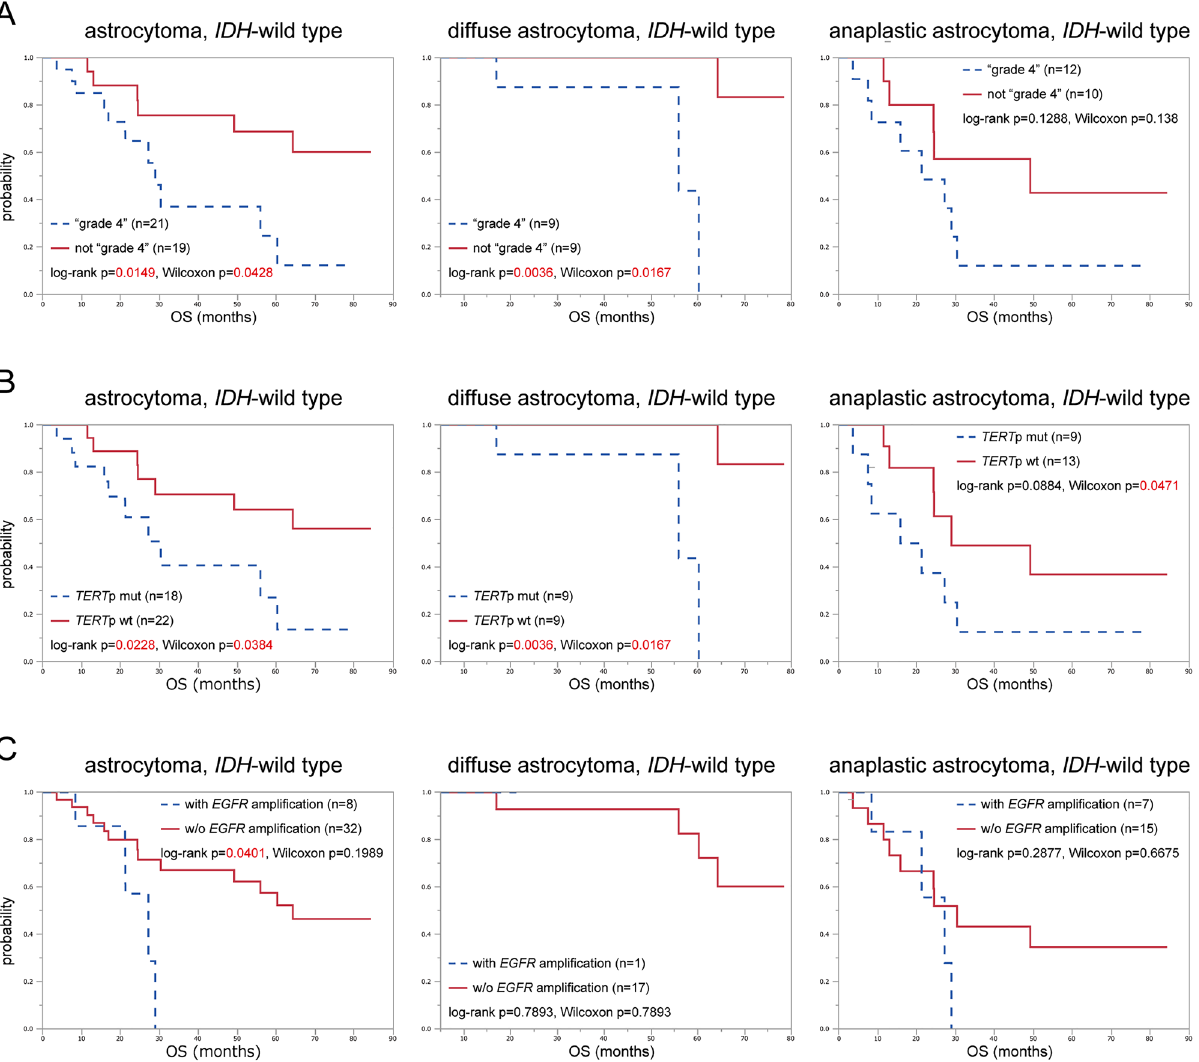
Figure 2. Survival analysis of 40 patients whose tumours were removed at their first surgery, were shown. The overall survival was analysed stratified by the following factors associated with the cIMPACT-NOW update 3 criteria; ( A ) the diagnosis of “astrocytoma, grade 4”, ( B ) TERT p mutation, or ( C ) EGFR amplification, in the groups of all IDH -wild type astrocytomas, IDH -wild type diffuse astrocytomas, and IDH -wild type anaplastic astrocytomas. The p values were calculated log-rank test and Wilcoxon test, and p < 0.05 was shown with red